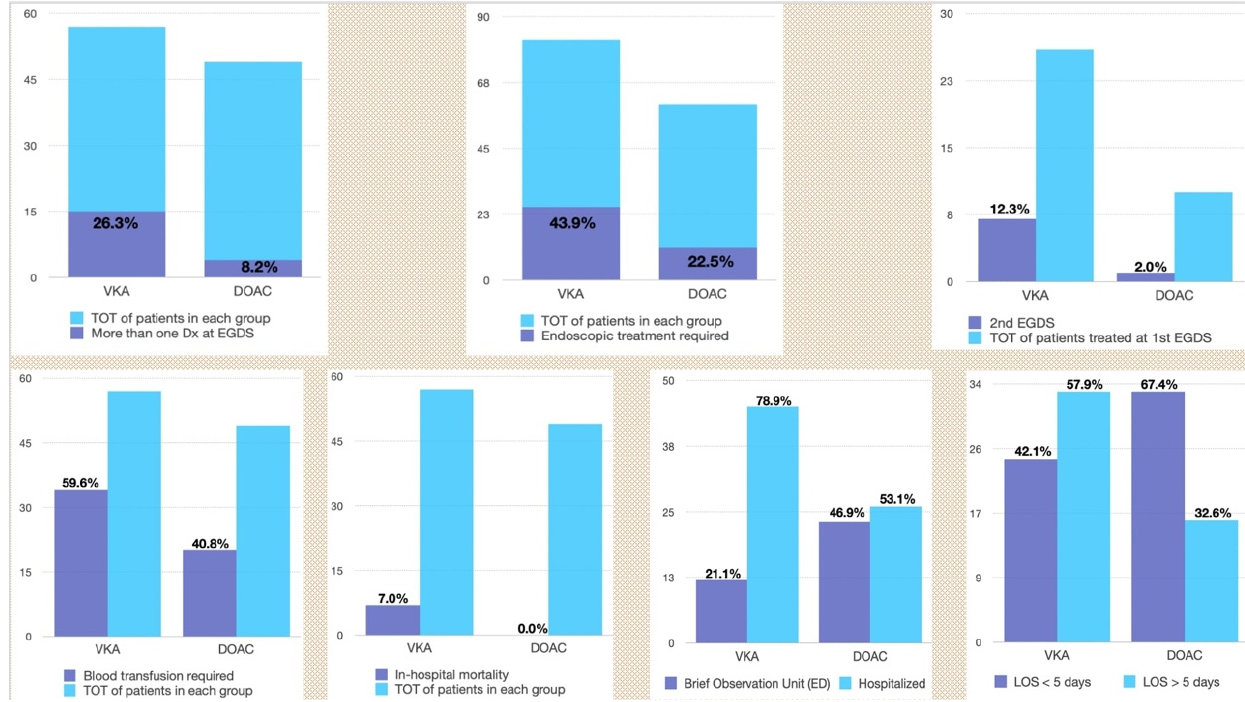
Figure 1. Outcomes of comparison of VKA vs. DOAC in severity of upper gastrointestinal bleeding: more than one diagnosis (top, left); need of endoscopic treatment (top, center); need to rescope (top, right); blood transfusion requirement (down, first graph); management in Brief Observation Unit (Emergency Department, down, second graph) or hospitalization (down, third graph); Length-of- stay of more than five days (down, fourth graph). List of abbreviations: Total (TOT); Vitamin-K antagonists (VKA); Direct oral anticoagulants (DOAC); Diagnosis (Dx); oesofagogastroduodenoscopy (EGDS); Emergency Department (ED); Length-of-stay